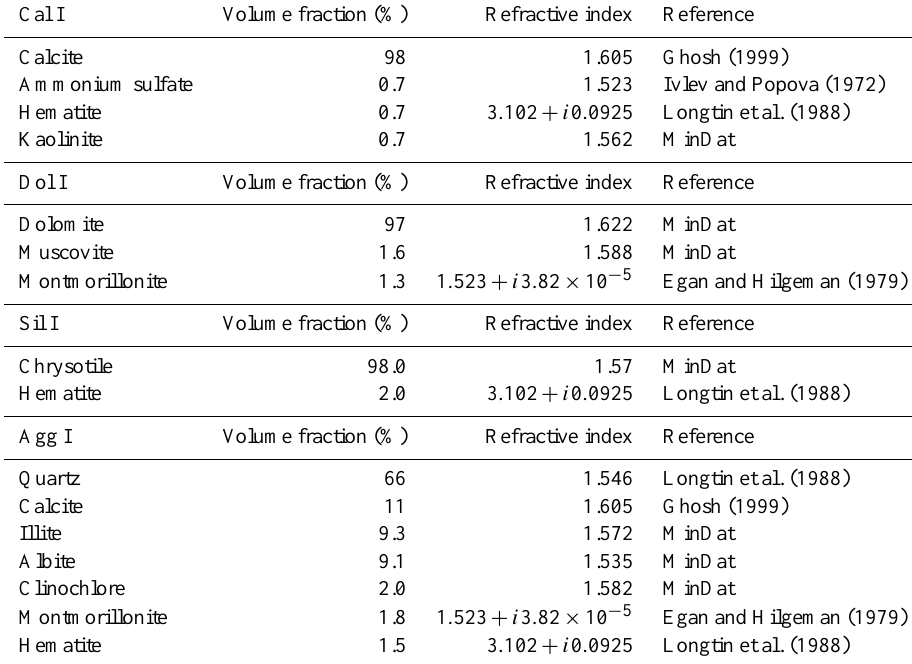
Fig. 2. Energy-dispersive spectroscopic images of the particle Agg I, based on which the elemental distribution and the composition of the particle were estimated (volume representation of the retrieved particle on the right). O and Na images show a pronounced shadowing effect towards the detector due to absorption of low-energy X-ray radiation inside the particle volume. Table 1. Mineralogical composition of the selected dust particles, and respective refractive indices at λ = 550 nm. MinDat stands for the web-based mineralogical database, http://www.mindat.org, where the information was retrieved in 2012. Cal I Volume fraction (%) Refractive